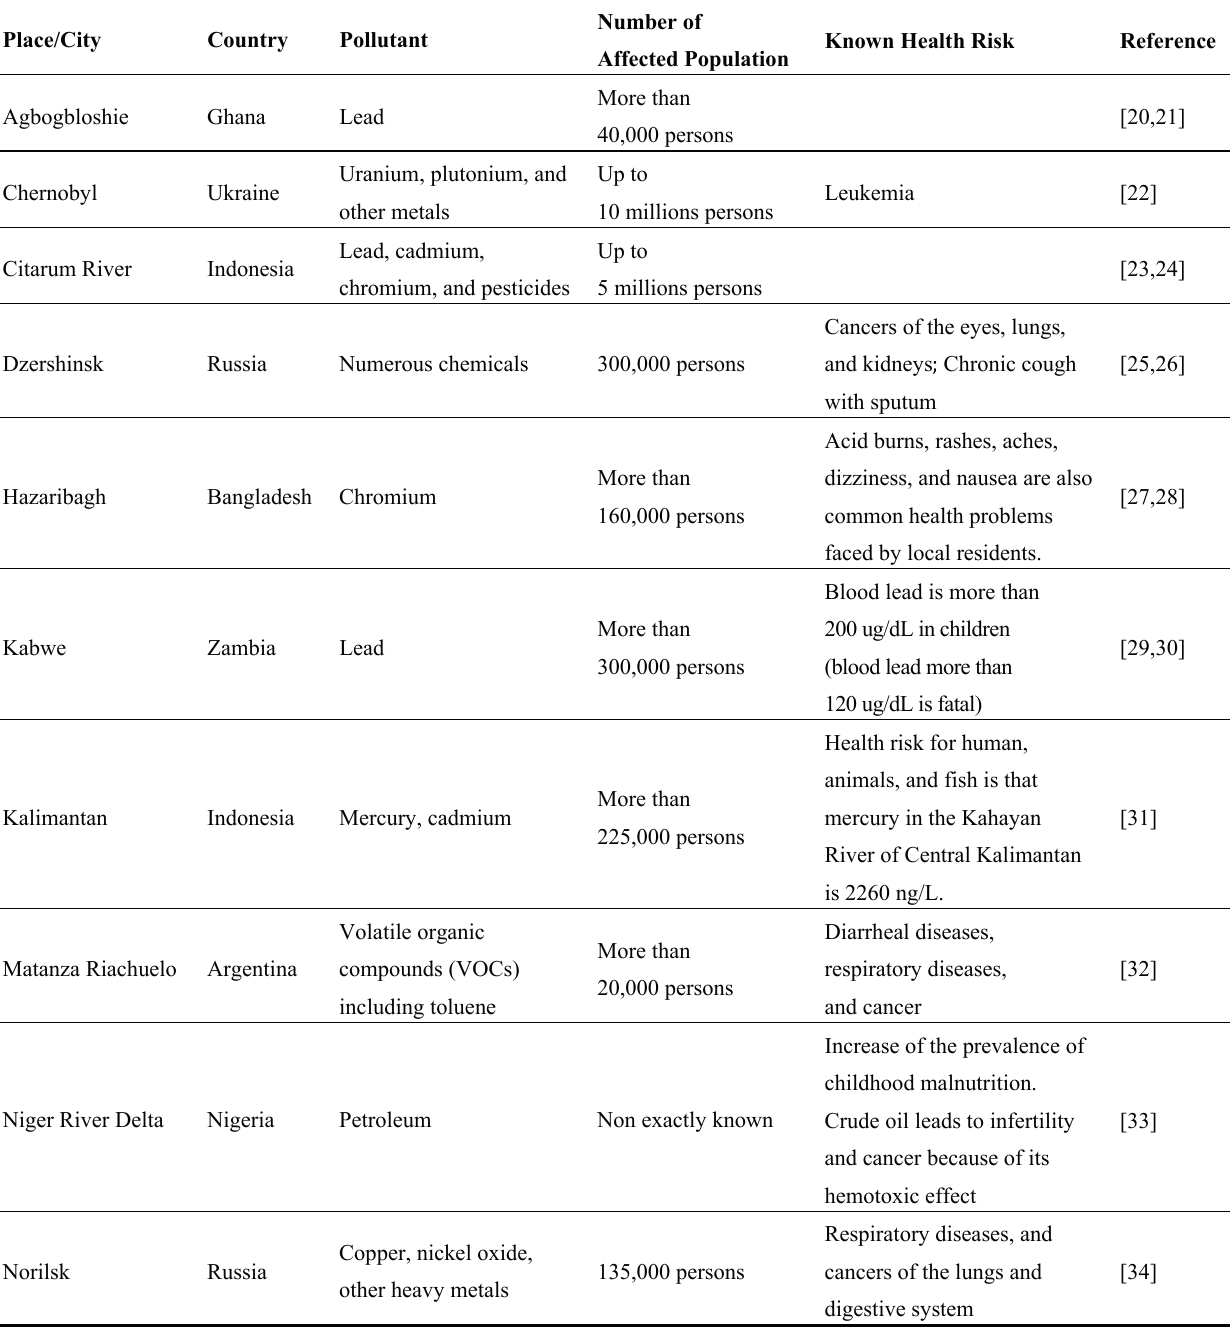
Table 1. The ten world’s worst polluted